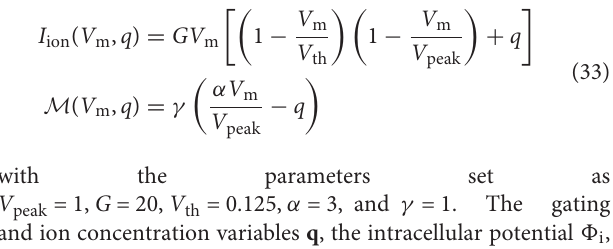
1 / 32 and spatial size h = 1 / 256. The membrane model is the Vfhn =